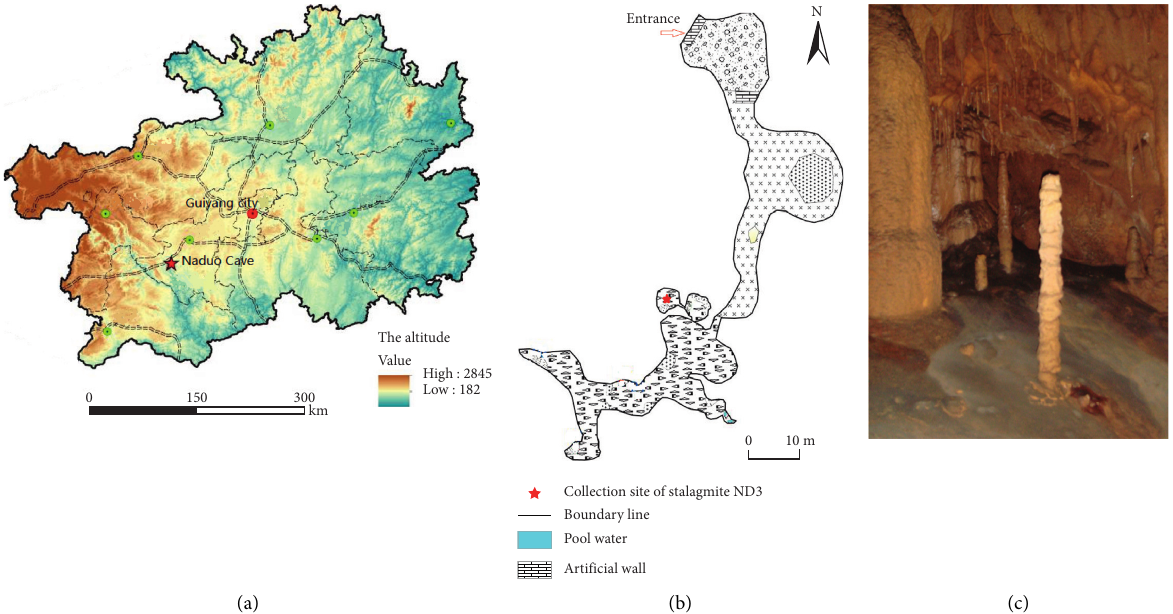
Figure 1: Stalagmite ND3 and the location and plan of Naduo